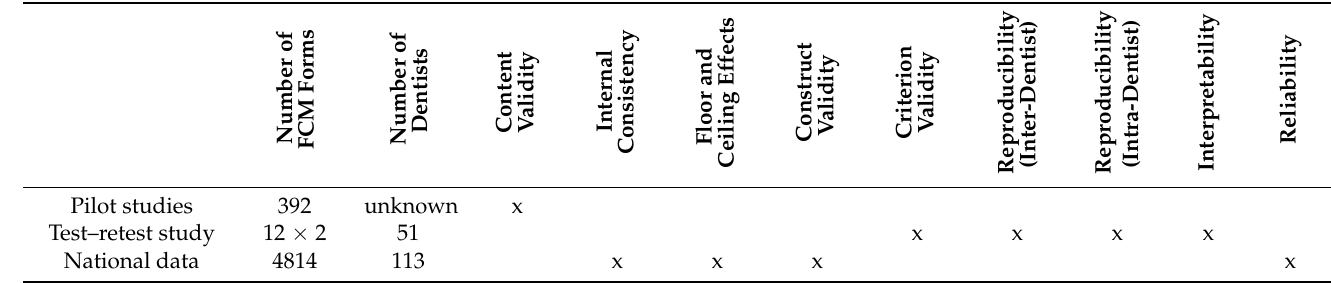
Table 1. Summary of the analysis undertaken to validate the French Case Mix